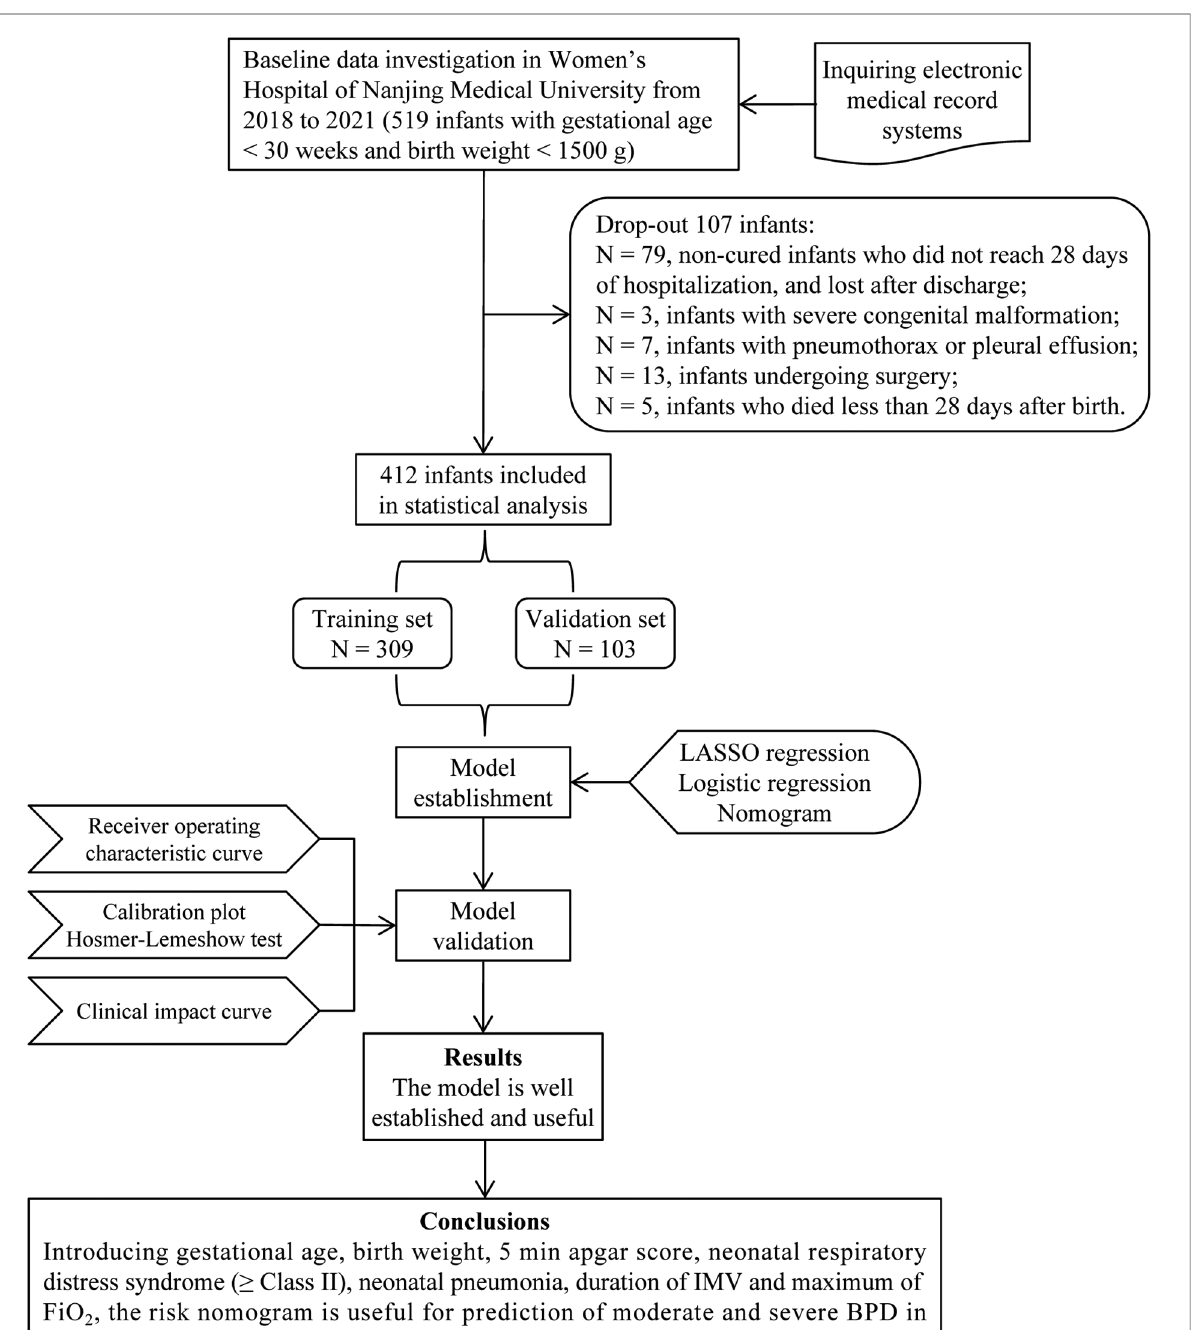
FIGURE 1 Flow diagram of study design. BPD, bronchopulmonary dysplasia; IMV, invasive mechanical ventilation; FiO 2 , fraction of inspiration O 2